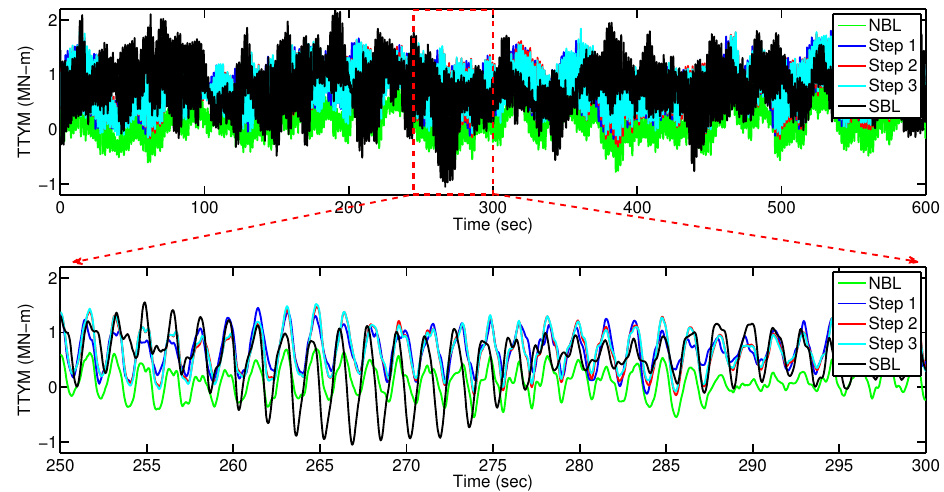
Figure 11. Comparison of tower-top yawing moment (TTYM) time series for a single case (control).